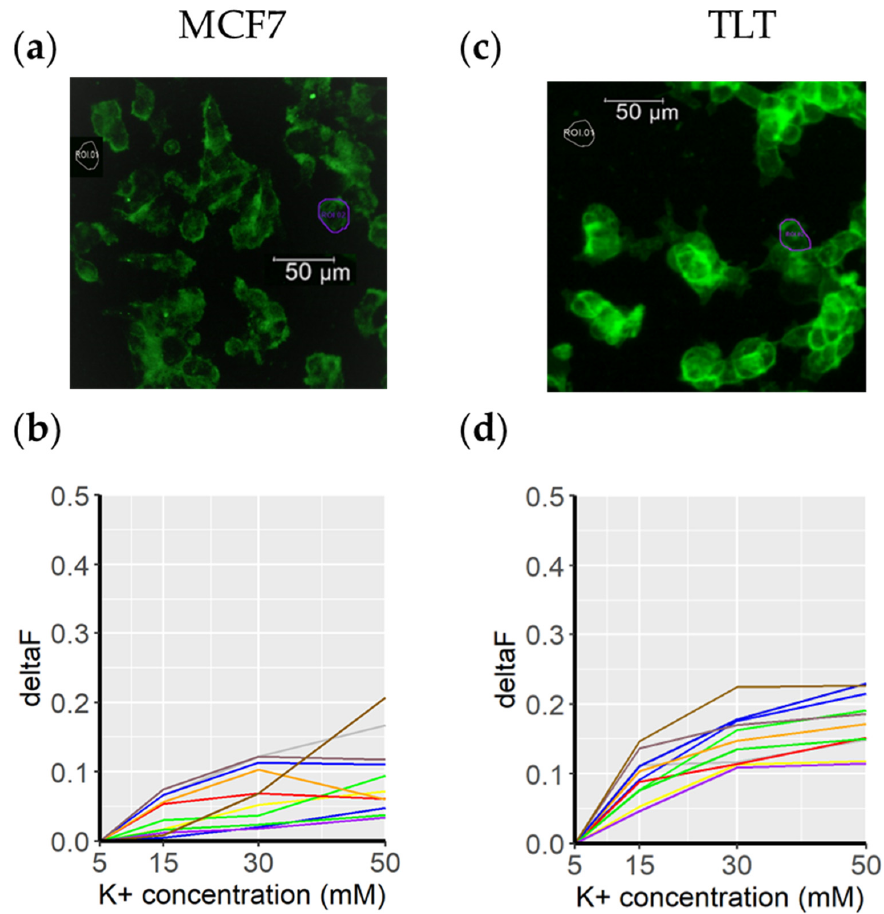
Figure 5. Fluovolt dye intensity in response to a depolarizing medium. ( a ) A representative image of MCF7 cells acquired with the FITC/GFP channel. The purple circle (ROI2) marks the cell in which the membrane potential was measured (for clarity, the other cells are not circled). The background signal is shown in gray and is labeled ROI1. The membrane potentials of the cells in this image are shown below, in ( b ) (each colored line represents a cell from the top image). Cells were cultured with cell culture medium in which the K+ concentration was gradually increased (from 5 mM to 50 mM. The same procedure was applied to the TLT cell line (subfigures ( c ) and ( d )).